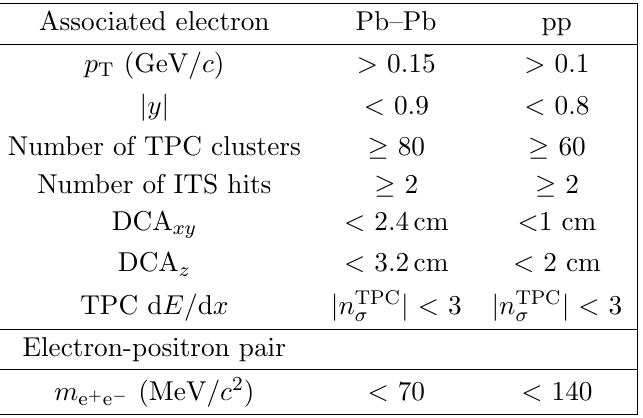
Table 4 . Selection criteria for tagging photonic electrons in Pb{Pb and pp